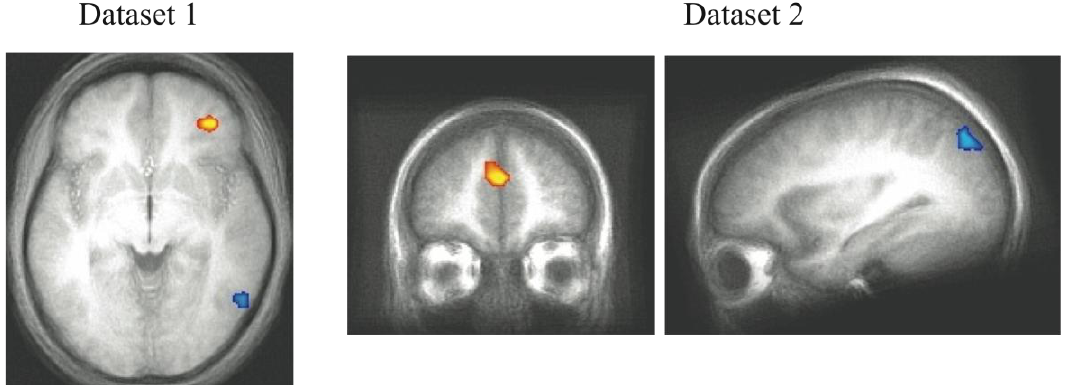
Figure 4. Correct trial activity for the best fitting RB versus best fitting II blocks. In Dataset 1 and Dataset 2, a region in right PFC is more active for best fitting RB blocks (red) and a region in right posterior visual association cortex is more active for best fitting II blocks